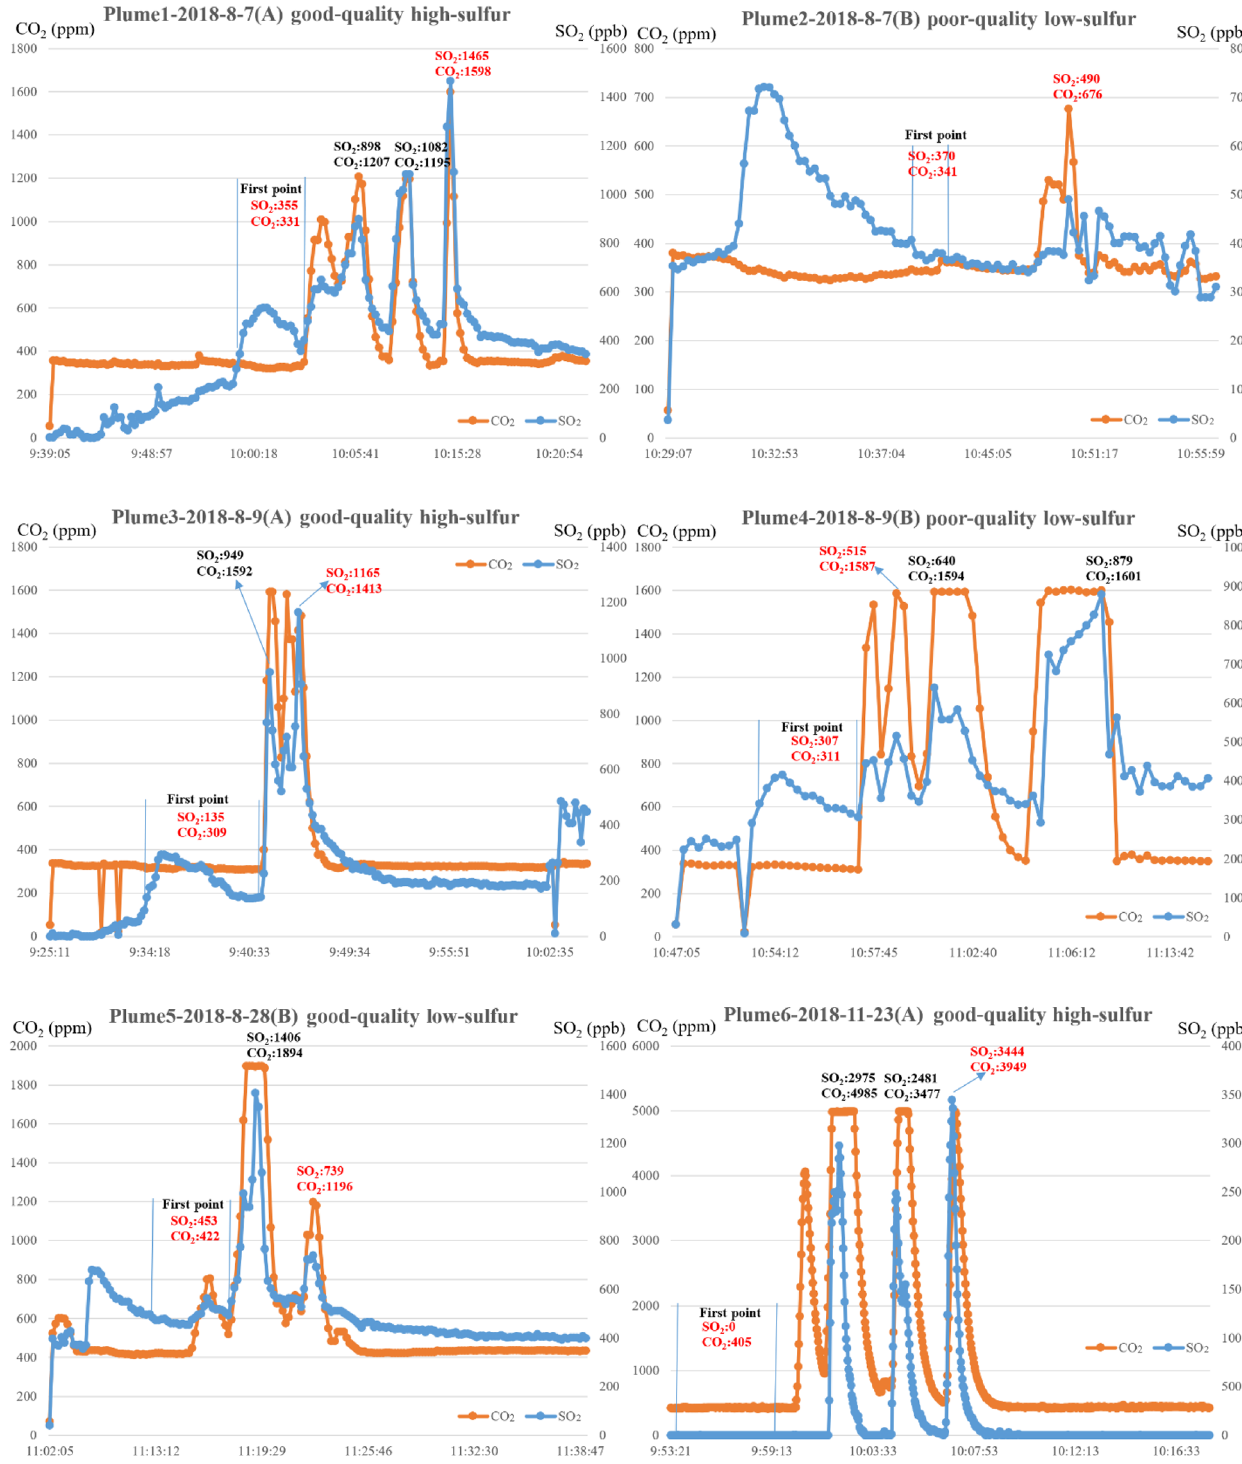
Figure 5. Six sets of plume measurement data for SO 2 and CO 2 , marked as plumes 1–6, along with the time and serial number. The background and peak values of SO 2 and CO 2 were used to estimate the FSC. In each plume, the time range of the first monitoring point is marked by two vertical lines. The selected background and peak values of SO 2 and CO 2 are written in red and alternative peak values are written in